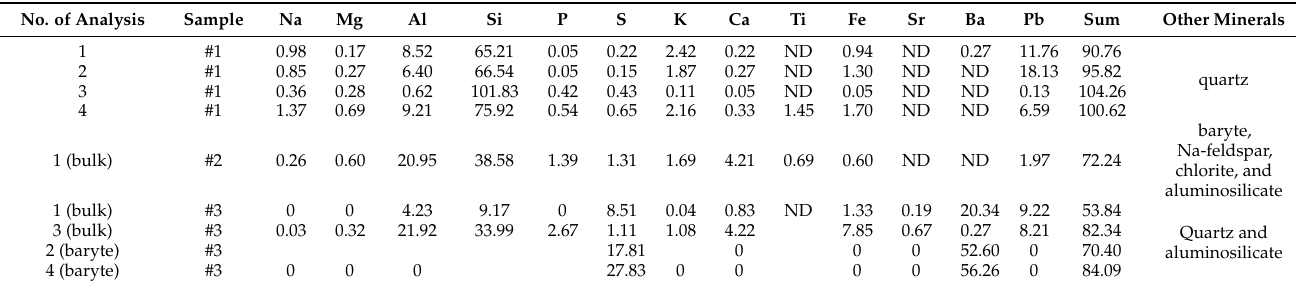
Table 1. EDX results of the three samples in wt%.